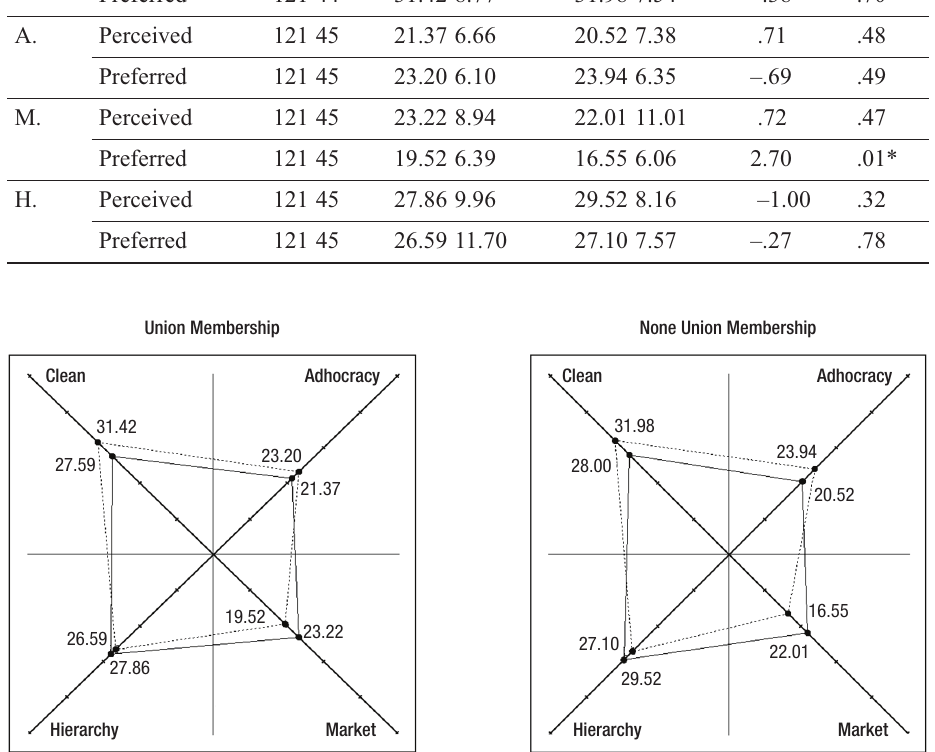
Fig. 5. Cultural profi les of the employees according to their union